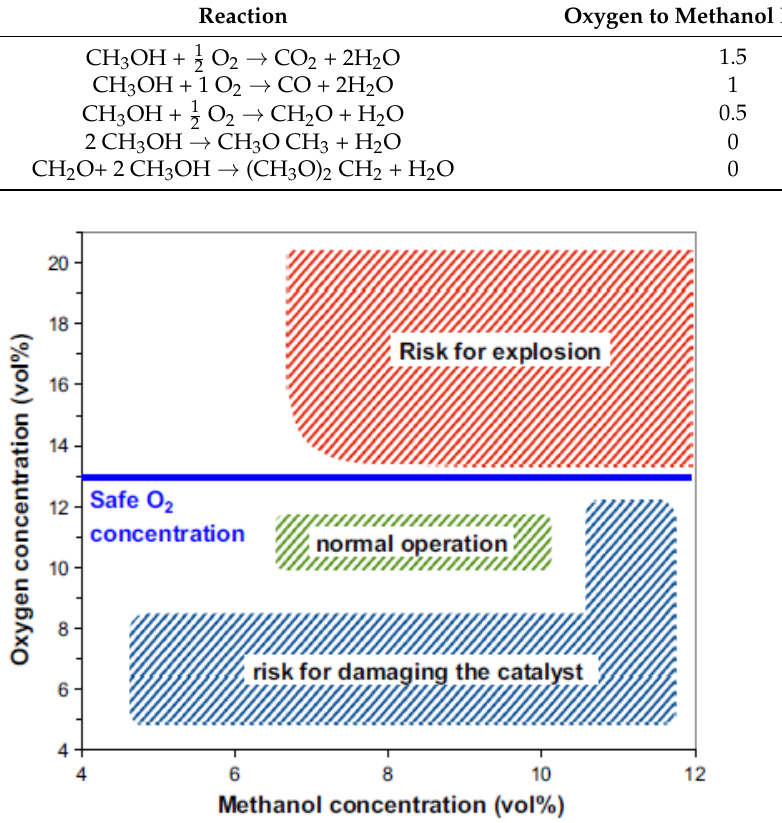
Figure 7. Feed concentration (methanol and oxygen) are presented in a small window. Reprint from [99]. Copyright (2021), with permission from Springer Nature.